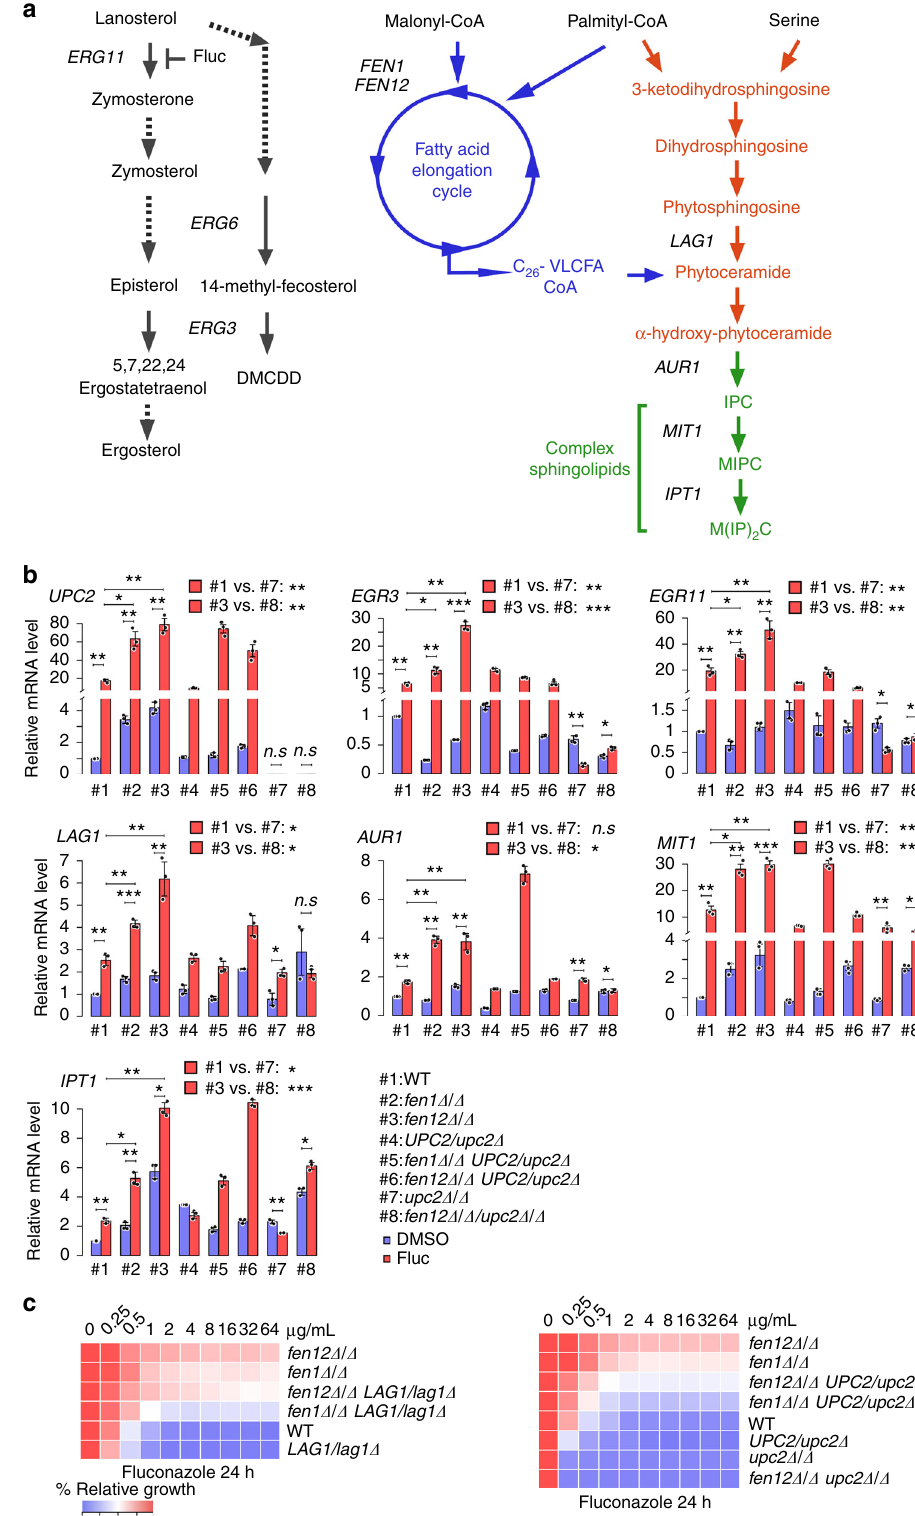
Fig. 6 Sphingolipid overproduction underlies fl uconazole resistance of fen Δ / Δ cells. a Illustration of ergosterol and sphingolipid biosynthesis pathways. b qPCR analysis of UPC2 , ERG3 , ERG11 , LAG1 , AUR1 , MIT1 , and IPT1 expression in WT, fen1 Δ / Δ , and fen12 Δ / Δ mutants with UPC2 single or double knockout in the presence or absence of fl uconazole. Error bars represent s.d. from the mean of three independent experiments. Signi fi cance was measured using unpaired t -test (* p < 0.05, ** p < 0.01, *** p < 0.001, n.s., not signi fi cant). c Fluconazole susceptibility of WT and the indicated mutants was evaluated